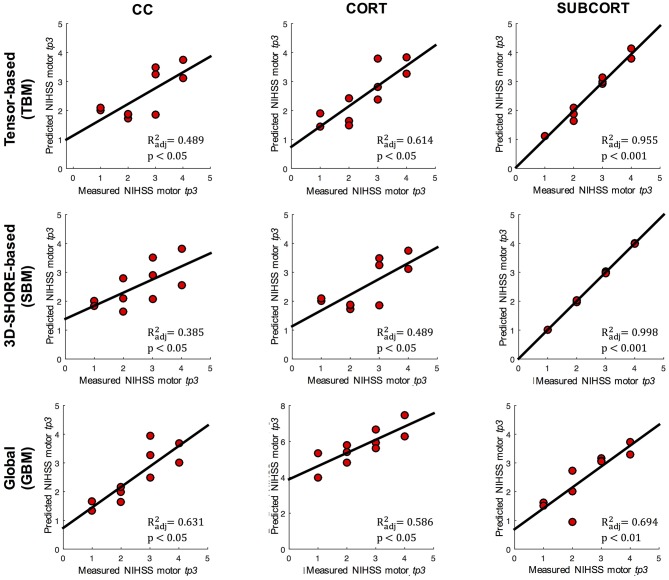
Linear regression models. Representation of the measured and predicted NIHSS-motor score at tp3 using tensor-based (TBM), 3D-SHORE-based (SBM), and global (GBM) predictive models. For each model, the adjusted R2 and corresponding p-values are reported.